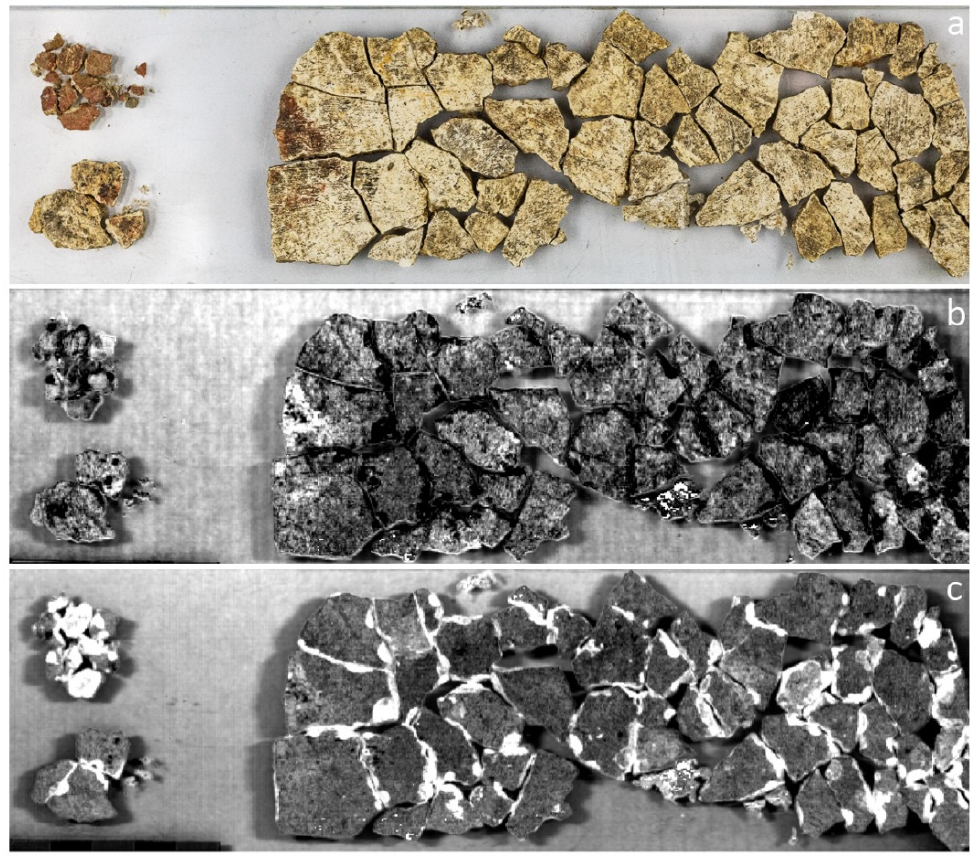
Figure 9. Results of the LSU classification obtained on a selection of samples. Visible color image ( a ); abundance map of the red ochre pigment ( b ); abundance map of the identified adhesive ( c ). Bright pixels represent higher abundance.